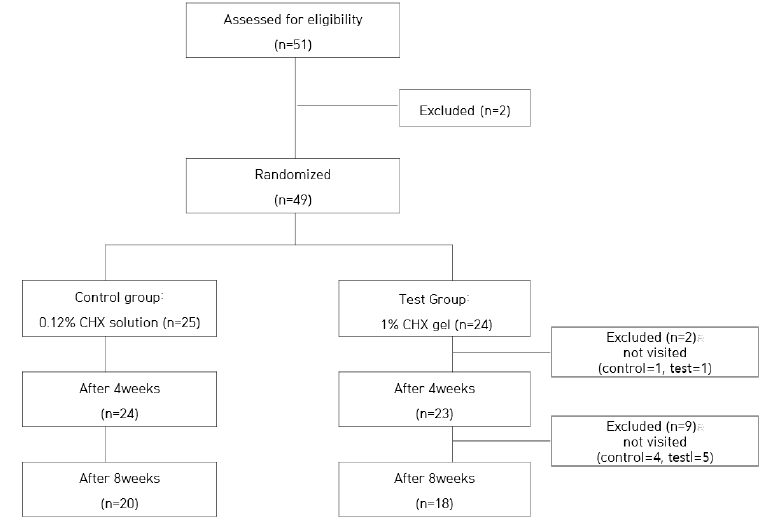
Figure 1. Flow chart of the participant selection process.